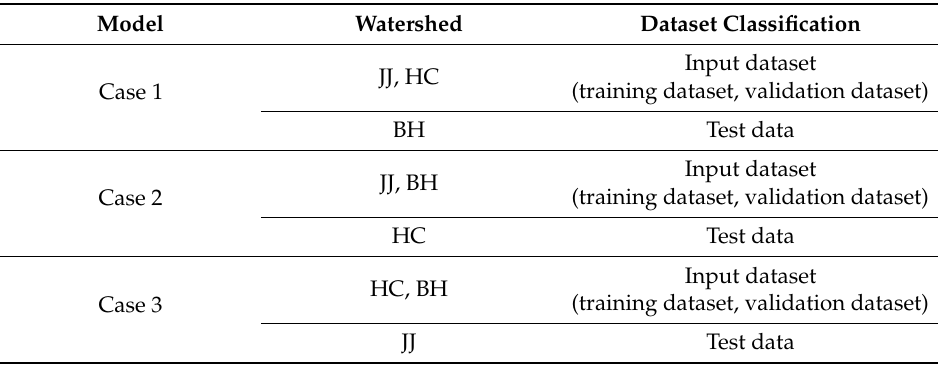
Table 3. Dataset